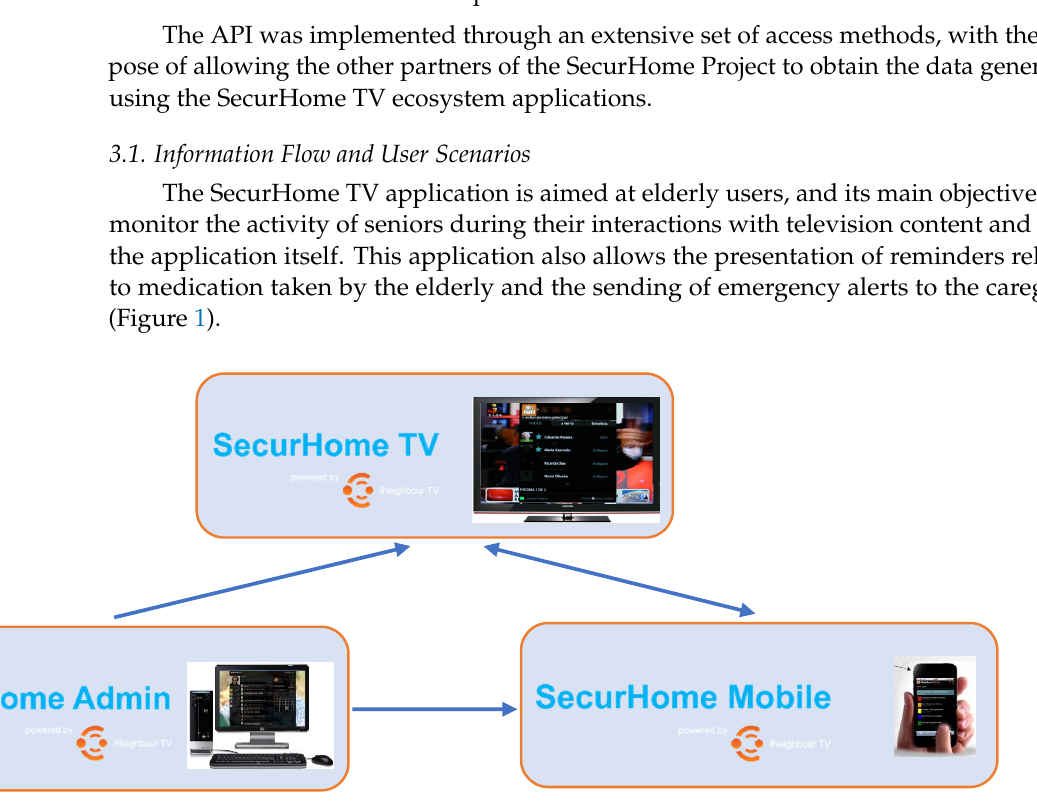
Figure 1. Information flow of the SecurHome TV ecosystem.